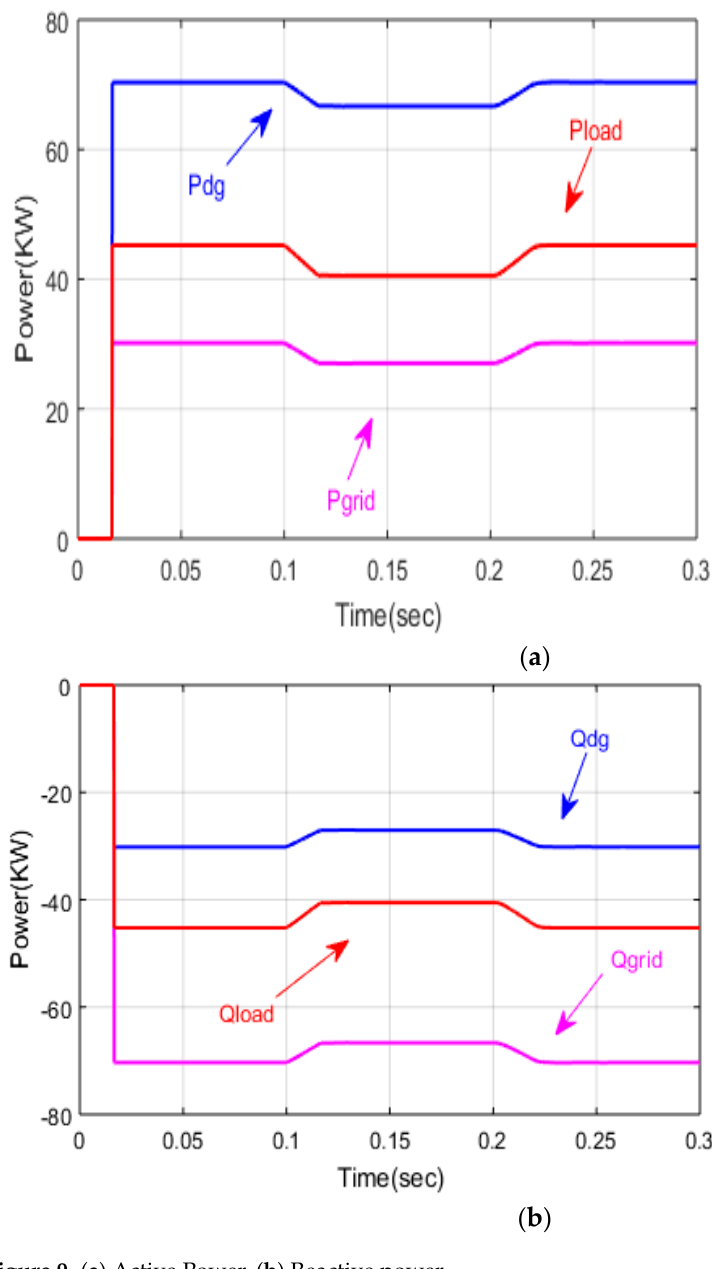
Figure 9. ( a ) Active Power, ( b ) Reactive power.